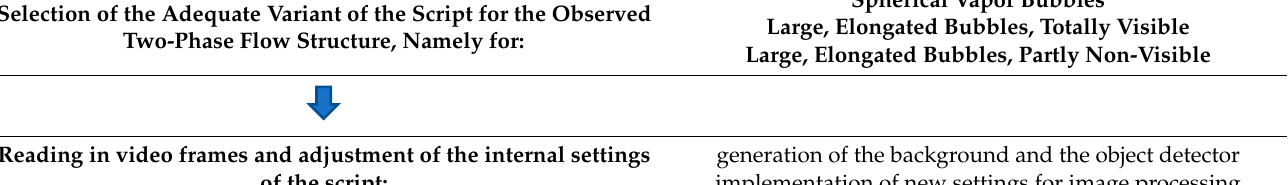
Table 1. Global scheme of the Matlab script